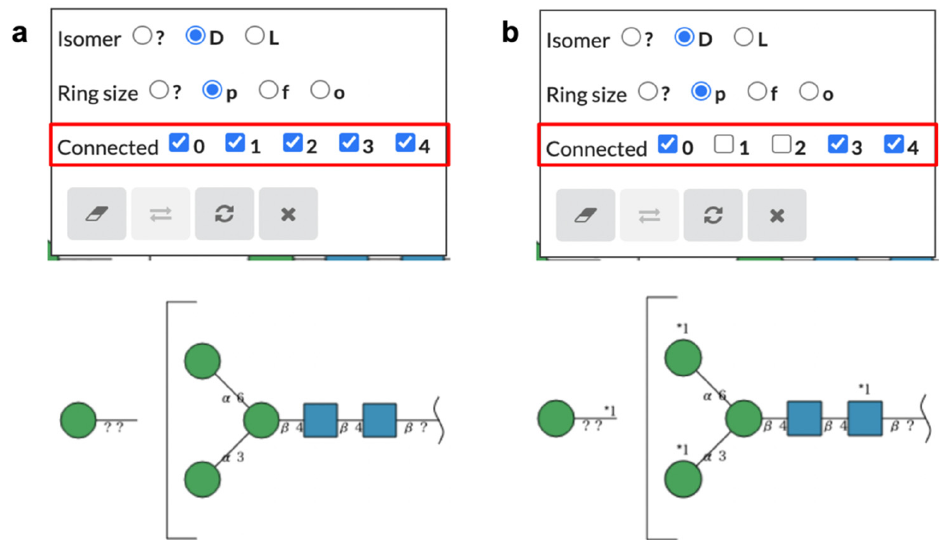
Figure 5. Windows for editing attachment sites of a fragment part. Users can edit attachment sites on the core part of glycan fragments by selecting the “Connected” checkbox in the pop-up window. If the attachment sites of a fragment part are specified, a number following “*” is assigned to the fragment part and the selected attachment sites are indicated by the number on the symbols of at- taching monosaccharides. ( a ) A view of the window and glycan when all attachment sites are se- lected and ( b ) when not all attachment sites are selected.